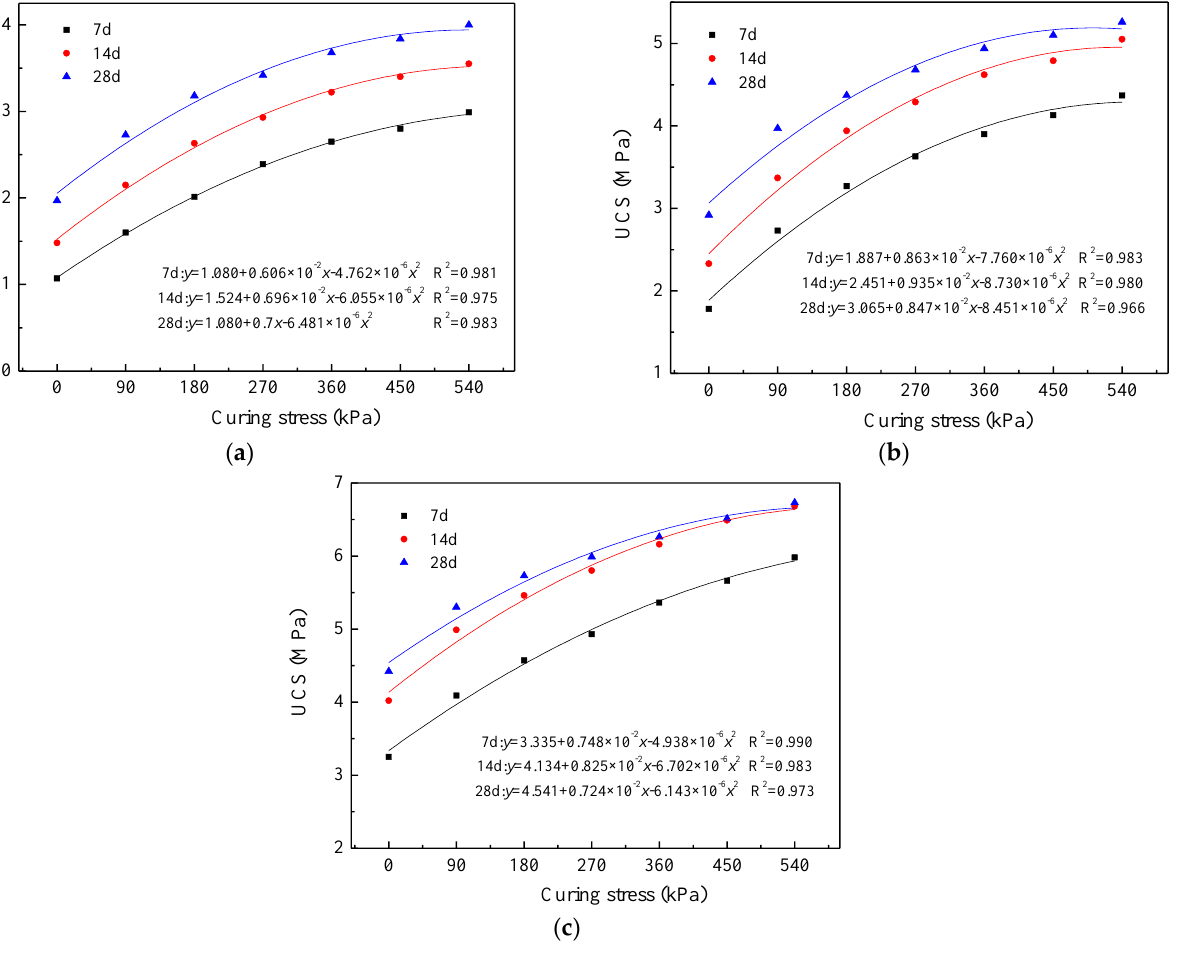
Figure 3. Relationship between the UCS and curing stress with different curing temperatures: ( a ) 20 °C; ( b ) 35 °C; ( c ) 50 °C.